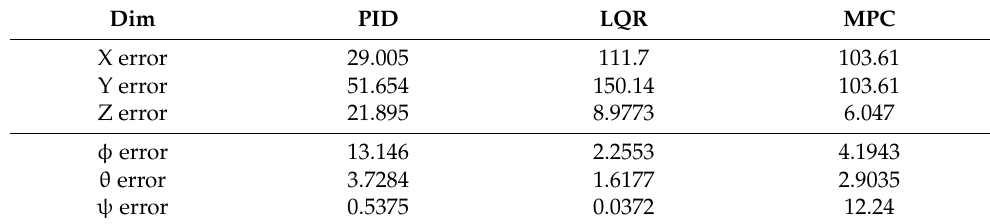
Table 3. Tracking errors of different controllers.